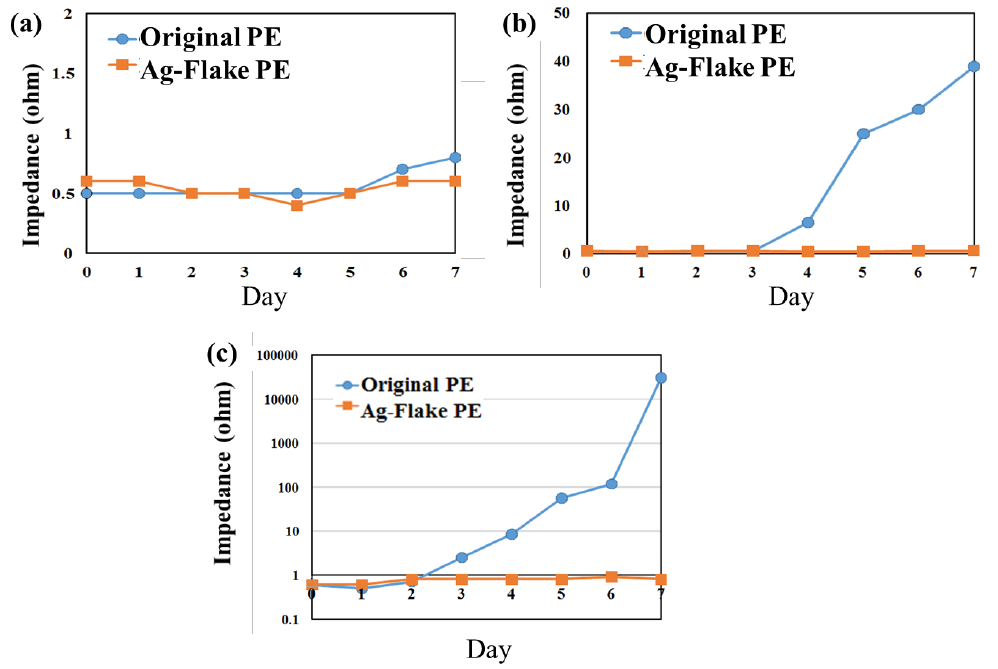
Figure 5. The variations of dry PEs (original PE (Ag/SiO2) and Ag-flake PE) surface impedance after salt spray testing with the saline concentrations of ( a ) 0.3%, ( b ) 3.0%, and ( c ) 5.0% for one week.